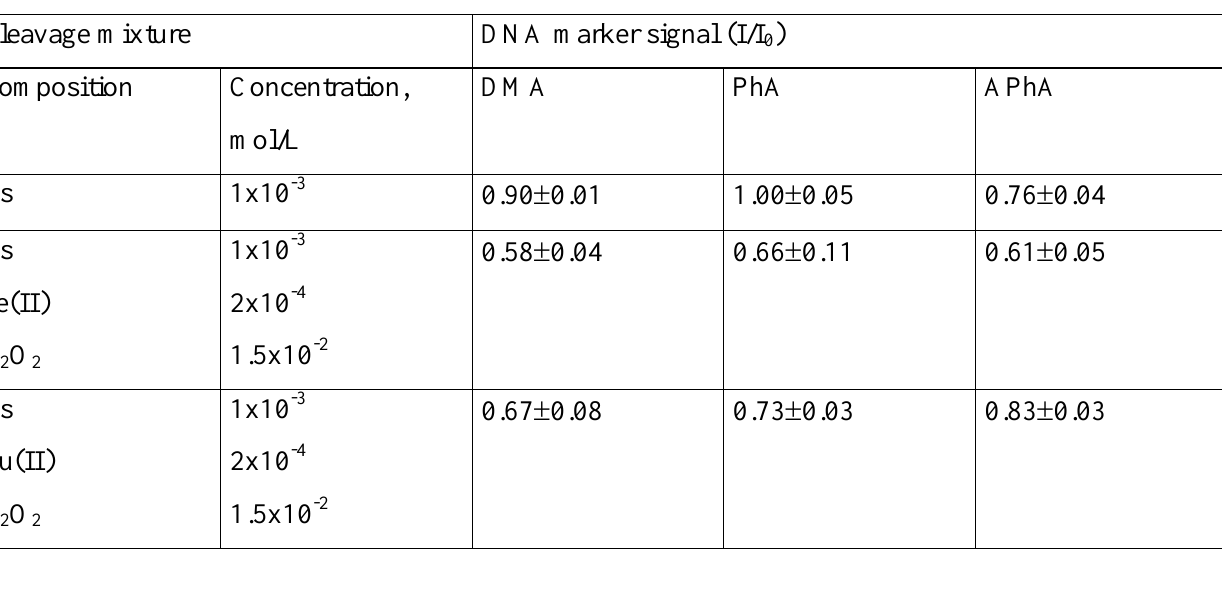
Table 3. Effect of organic arsenic species on DNA at 10 min incubation of DNA/SPE sensor in cleavage mixtures with Fe(II) and Cu(II) ions. Conditions: 1x10 -2 mol/L phosphate buffer solution pH 7.0 under